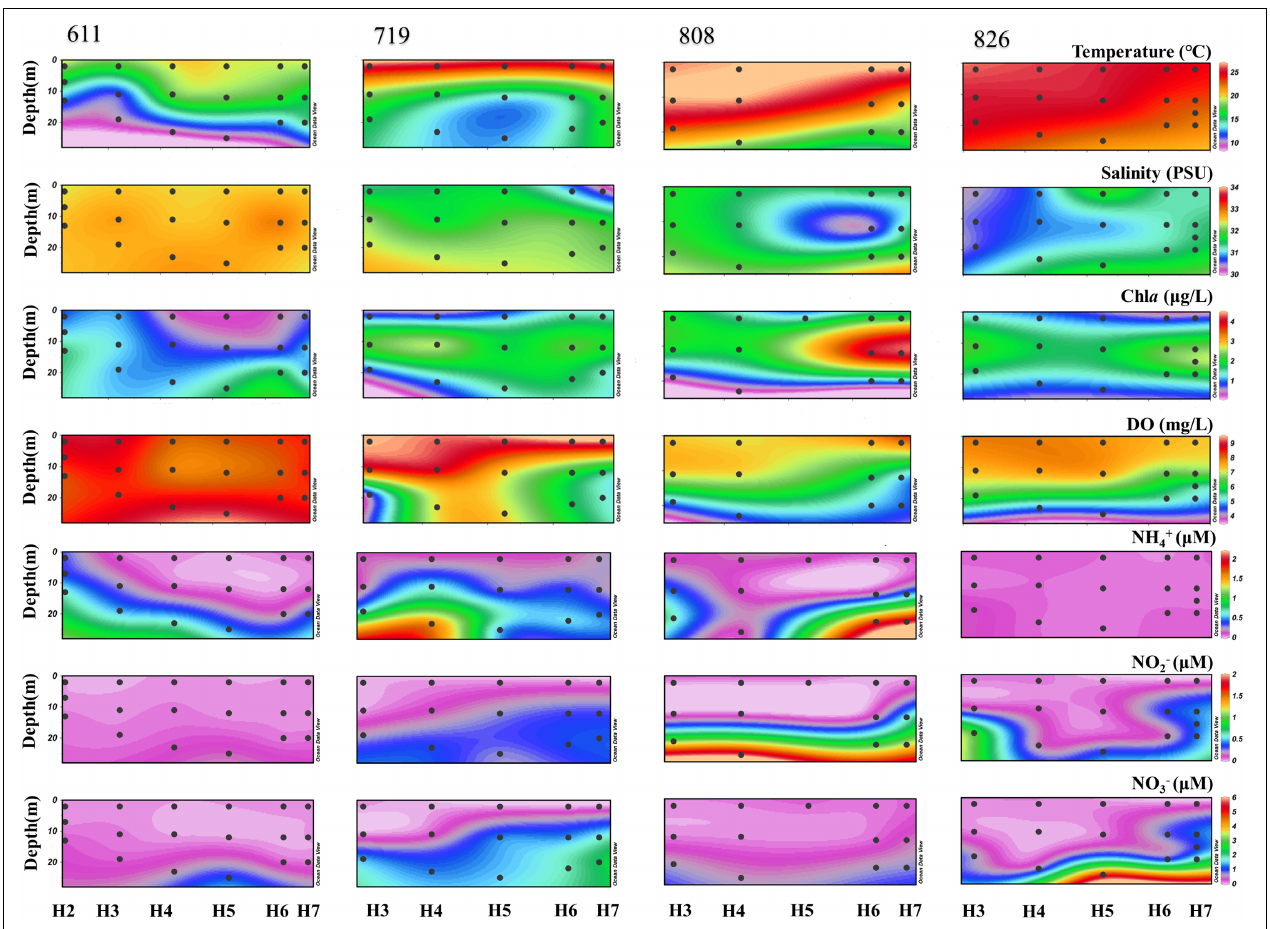
FIGURE 2 | The vertical profile of biogeochemical parameters (temperature, salinity, Chl a , DO, NH 4 + , NO 3 − , and NO 2 − ) of each water sample.